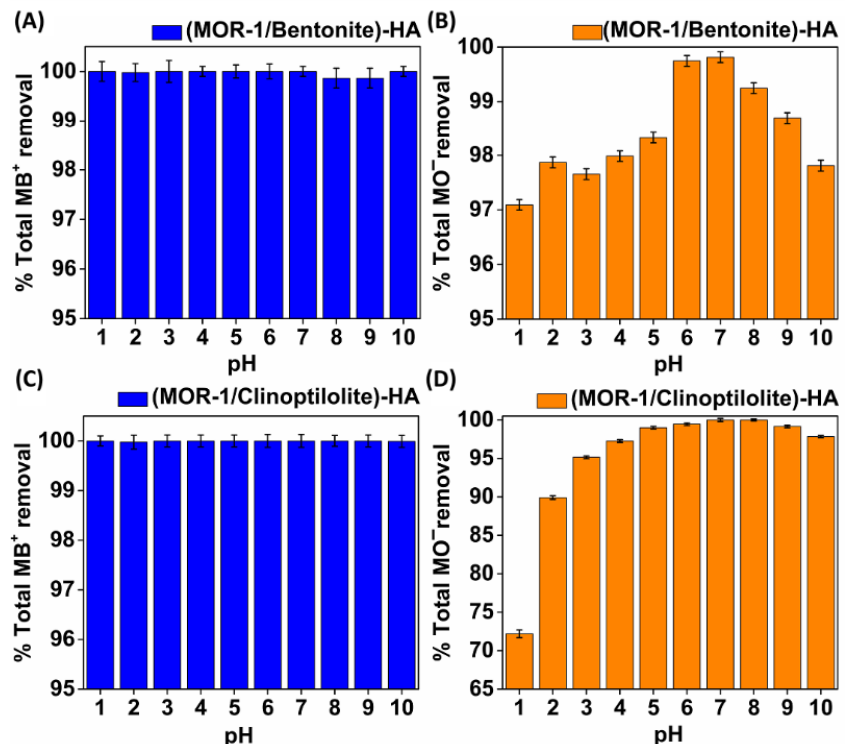
Figure 8. Percentage of sorption of ( A ) MB + and ( B ) MO − by (MOR-1/Bentonite)-HA ; ( C ) MB + and ( D ) MO − by (MOR-1/Clinoptilolite)-HA in the pH range of 1 – 10.